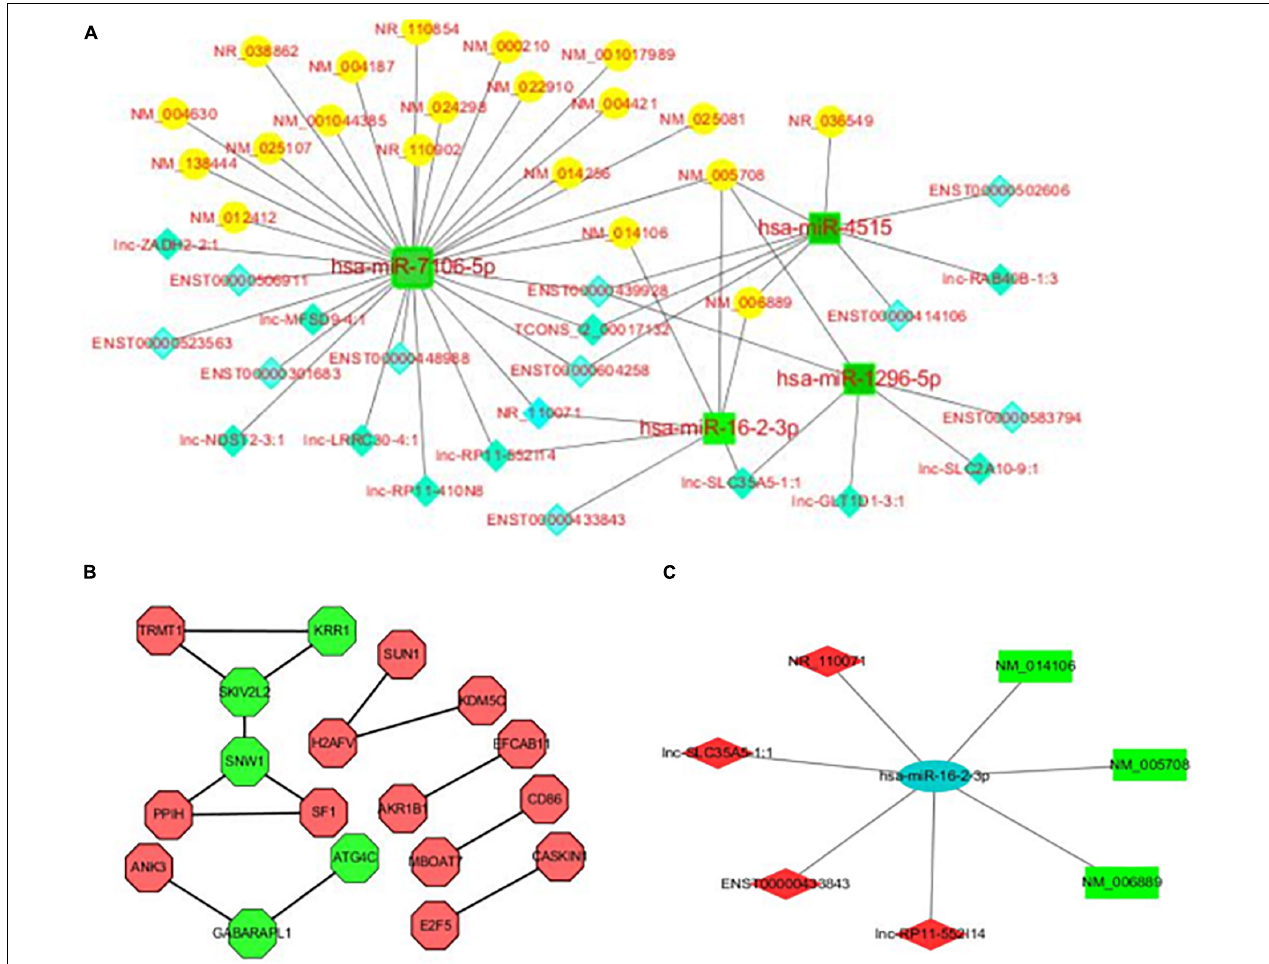
FIGURE 3 | (A) LncRNA-miRNA-mRNA ceRNA regulatory network in the plasma of rare-earth pneumoconiosis patients. The blue diamond is lncRNA, the green square is miRNA, and the yellow circle is mRNA. (B) Differentially expressed mRNA PPI network in rare-earth pneumoconiosis patients. Green hexagons are the top 5 genes. (C) Hsa-miR-16-2-3p related ceRNA regulatory network in the plasma of rare earth pneumoconiosis patients. The blue ellipse is miRNA, the green rectangle is mRNA, and the red quadrilateral is